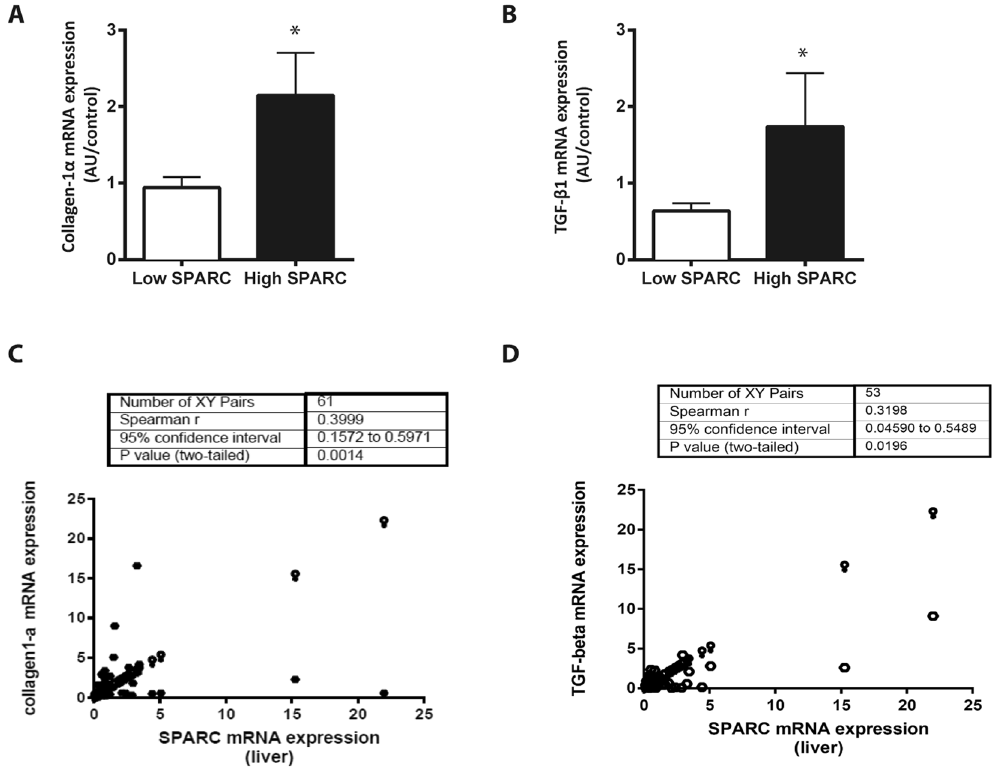
Figure 2. Pro-fibrogenic gene expression is increased in patients with NAFLD and high SPARC expression. NAFLD patients were grouped by hepatic SPARC mRNA expression. Patients with high SPARC expression had significantly higher collagen 1 alpha ( A ) and TGF-beta ( B ) mRNA expression in the liver. Data are mean ± sem, * p < 0.05. Comparison between groups was performed with Mann-Whitney U Test. mRNA expressions of both pro-fibronic genes were significantly correlated to SPARC expression ( C , D ). Spearman rank